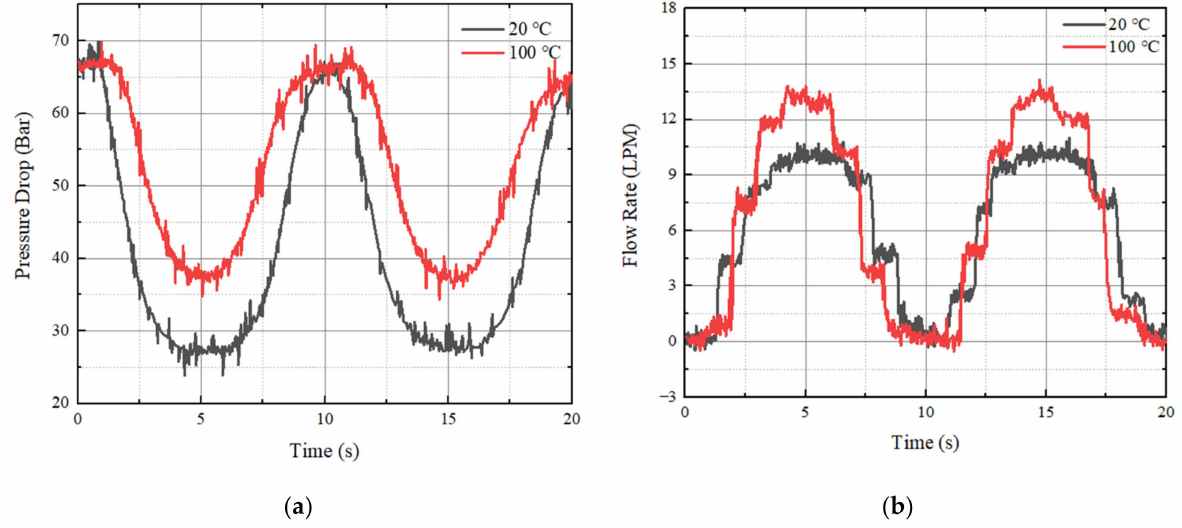
Figure 16. Measured pressure drop and flow rate with the input voltage of V ( t ) = 65sin ( 0.2 π t ) + 65 ( V ) ; ( a ) pressure drop and ( b ) flow